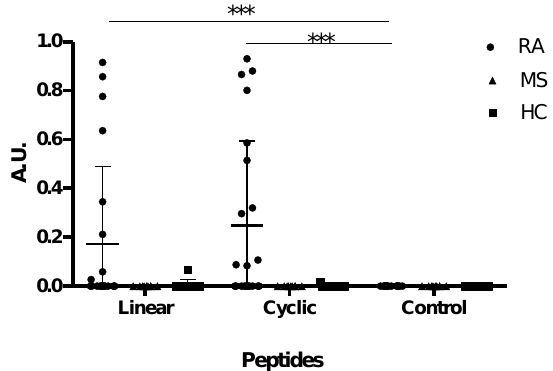
Figure 1. Reactivity of rheumatoid arthritis (RA), healthy control (HC) and multiple sclerosis (MS) sera to α-enolase peptides (KIHARCEIFDS-Cit-GNPTVEC) analysed by traditional ELISA. A linear Arg-containing peptide (KIHARCEIFDS-R-GNPTVEC) was used as negative control. HC and MS sera were used as controls. A.U. were defined as absorbances normalized relative to a positive RA control pool. p values less than 0.001 are shown as ***.